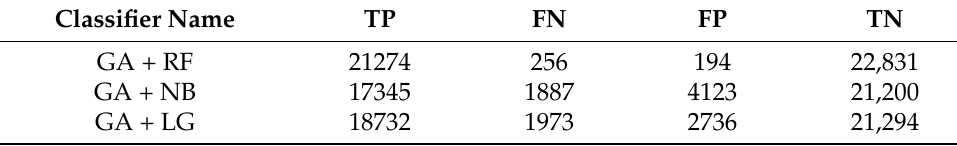
Table 6. Average comparison of the confusion matrix for the proposed